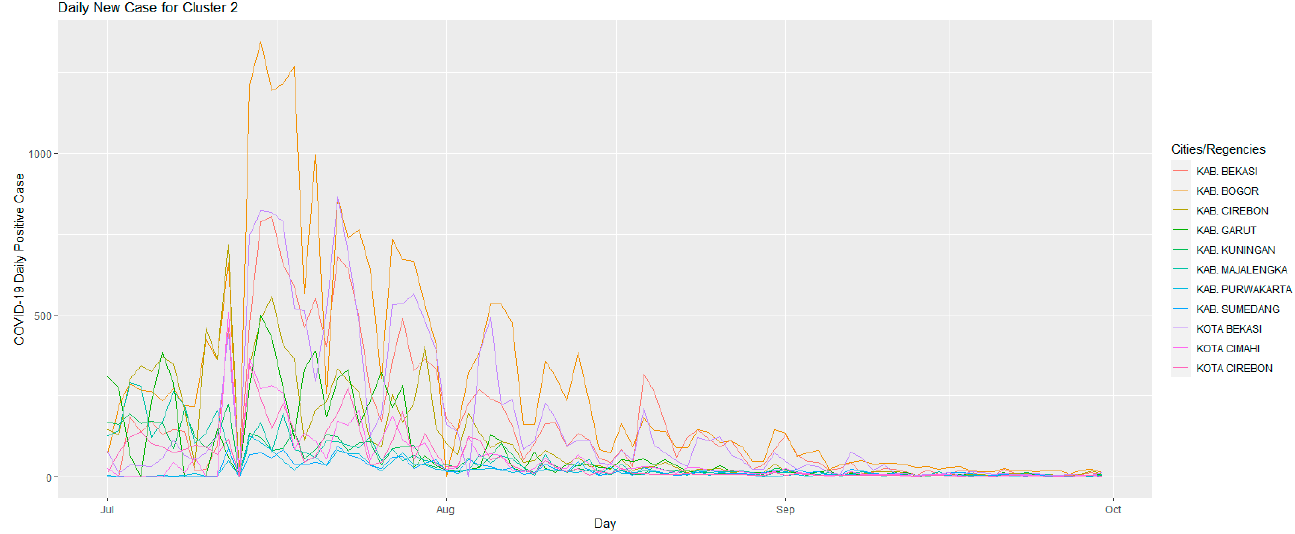
Figure 5. Daily positive cases of COVID-19 in Cluster 2 for the first period.